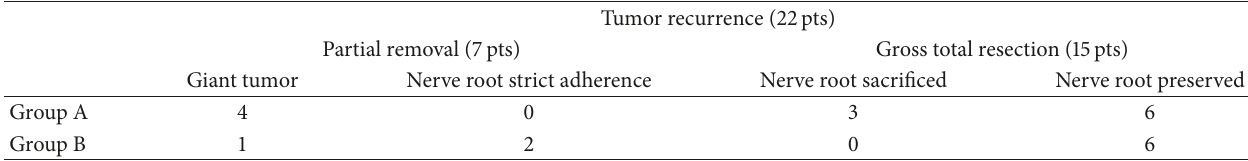
Table 4: Tumor recurrence related to partial or complete surgical removal. No significant difference between recurrence percentages in group A and group B was noted. However, data were not statistically strong enough to draft definitive